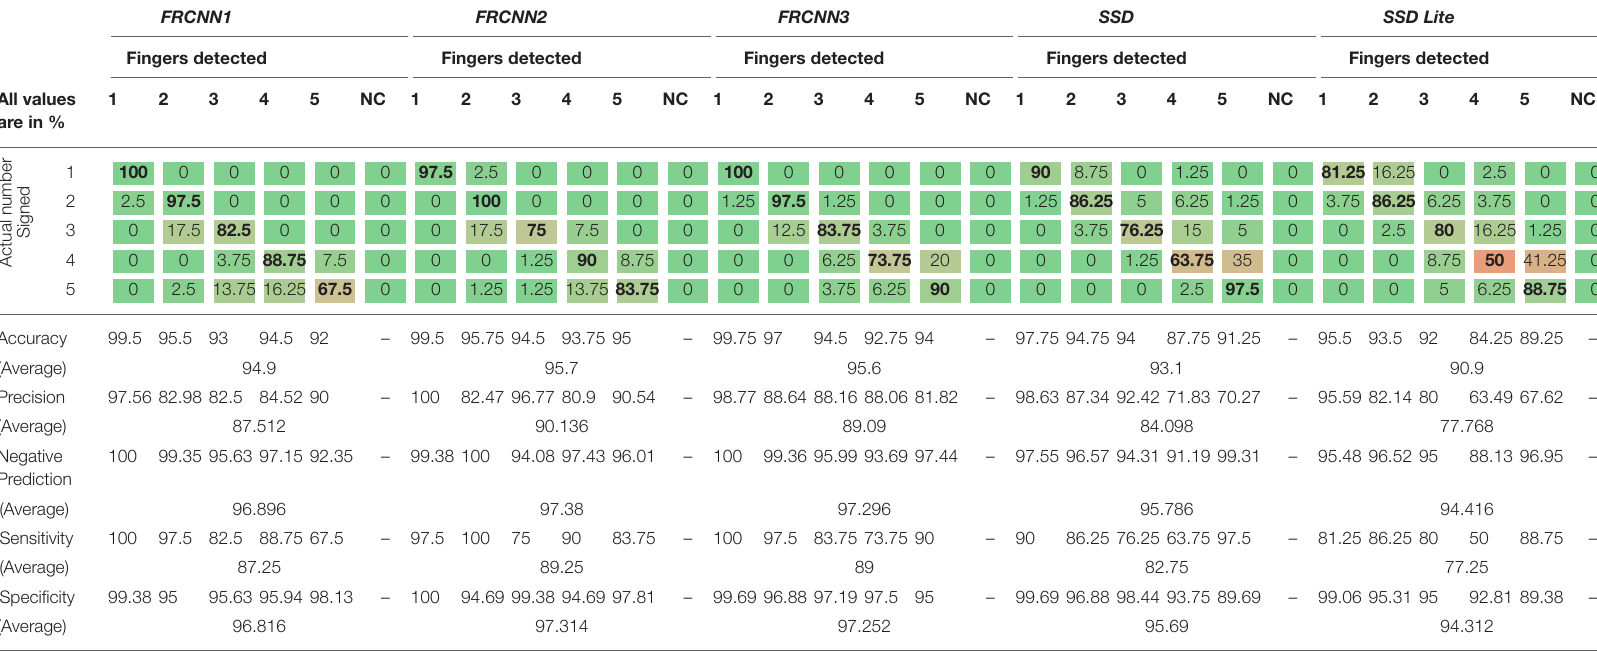
TABLE 3 | Results of the detection using the five example networks. FRCNN1 FRCNN2 FRCNN3 SSD SSD Lite Fingers detected Fingers detected Fingers detected Fingers detected Fingers